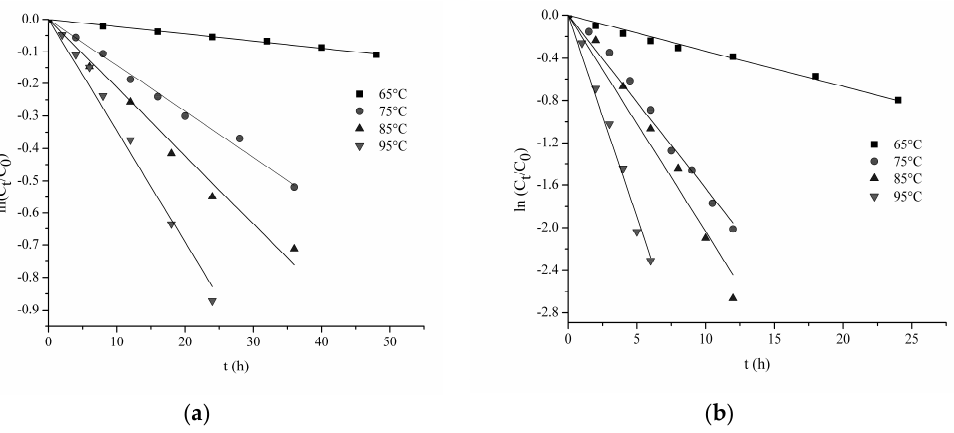
Figure 4. First-order plots for HSYA degradation in aqueous solution ( a ) and XBJ injection ( b ).